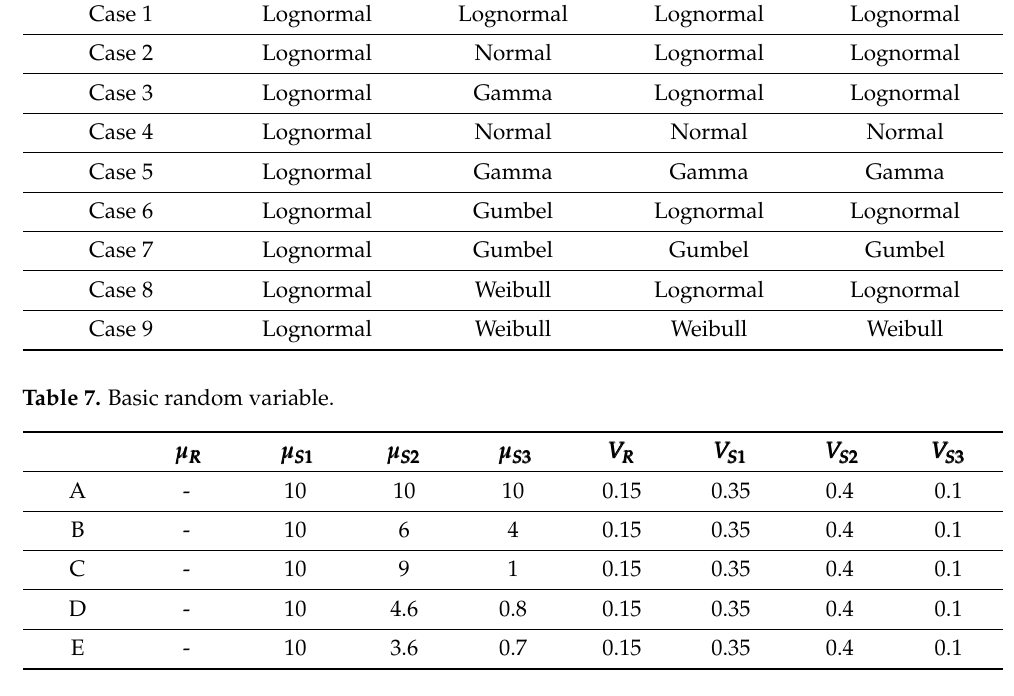
Table 6. Distribution types of the random variables.